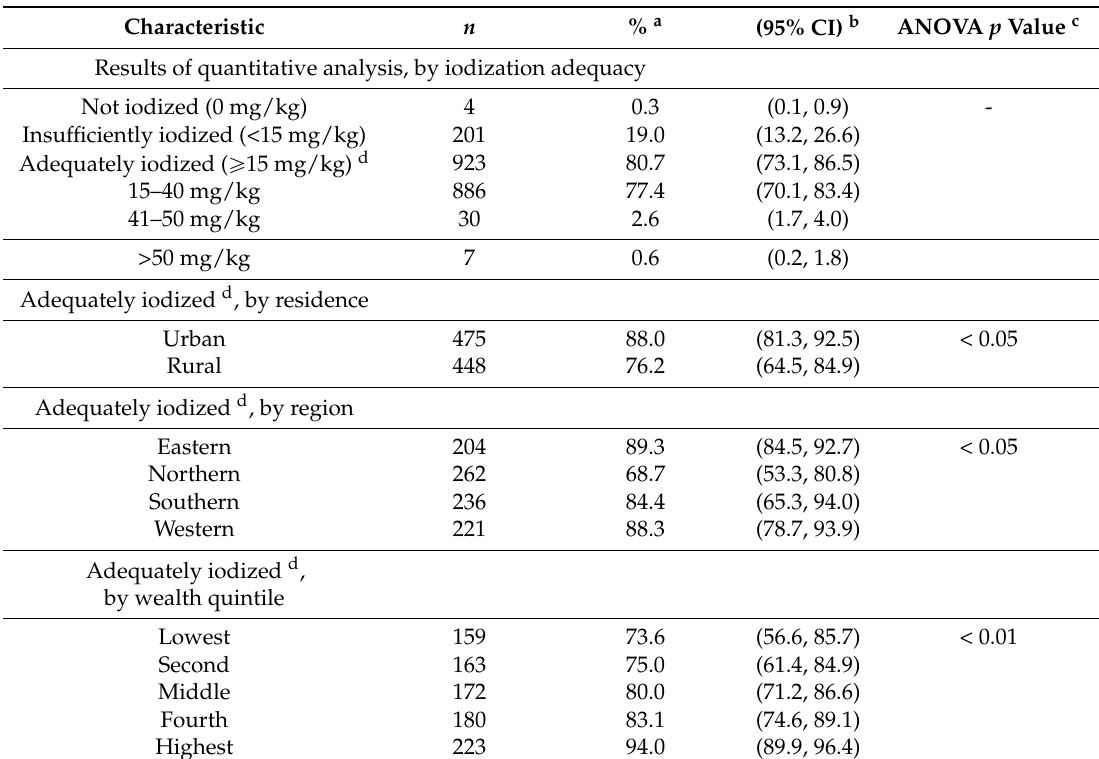
Table 1. Weighted distribution of household salt iodine levels and of adequately iodized salt, Sierra Leone, 2013.